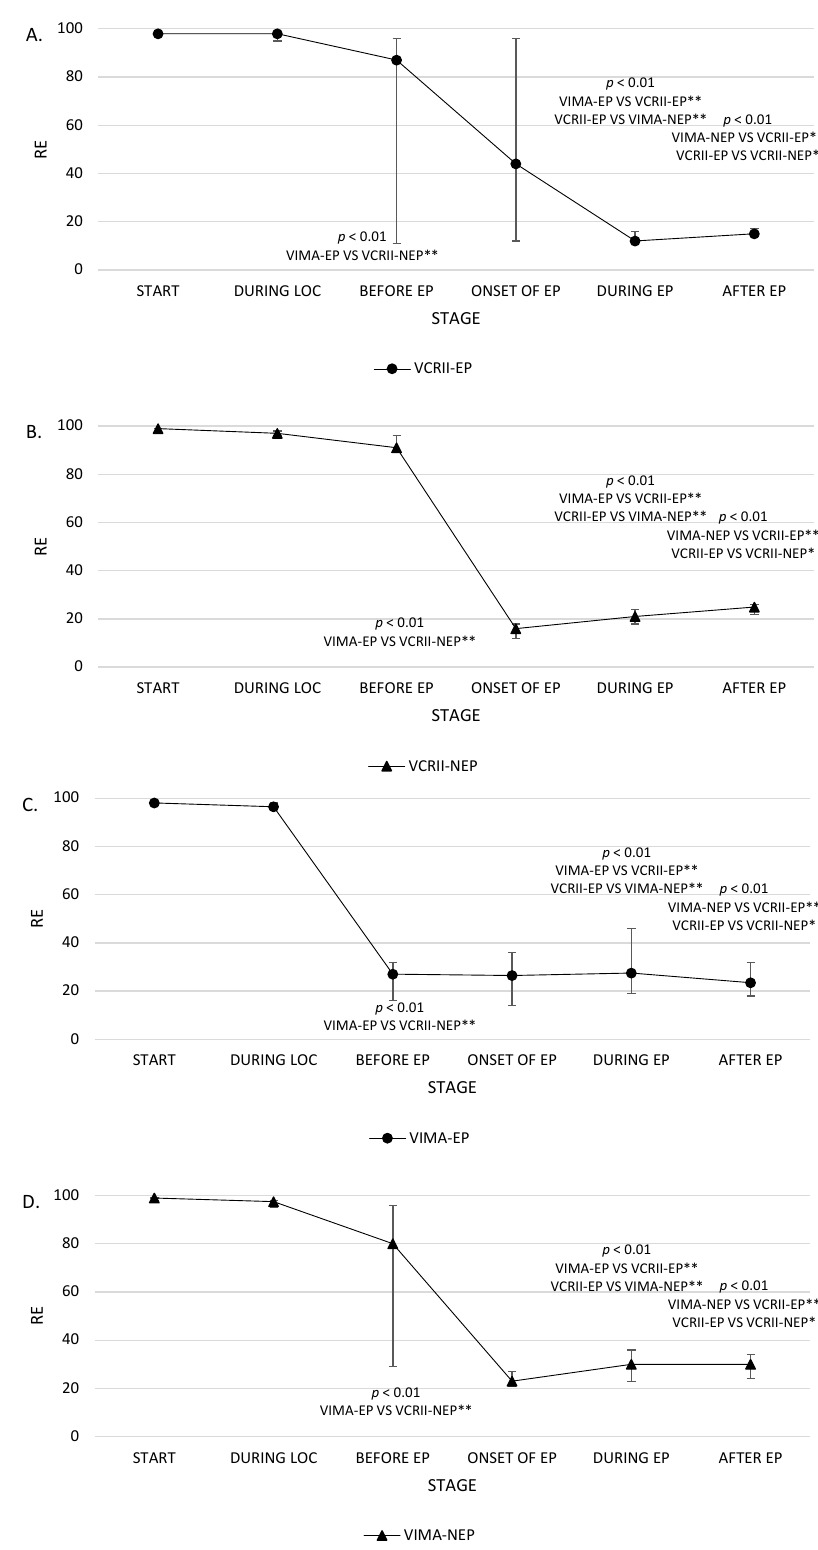
Figure 2. Median values M (IQR) of response entropy (RE) in groups: ( A ) volatile-vitalcap-EPI (VCRII-EP), ( B ) volatile-vitalcap-NOTEPI (VCRII-NEP), ( C ) (VIMA-EP), ( D ) (VIMA-NEP), on separate stages of the study, indicating a sequence of events ( p -values: * < 0.05, ** <